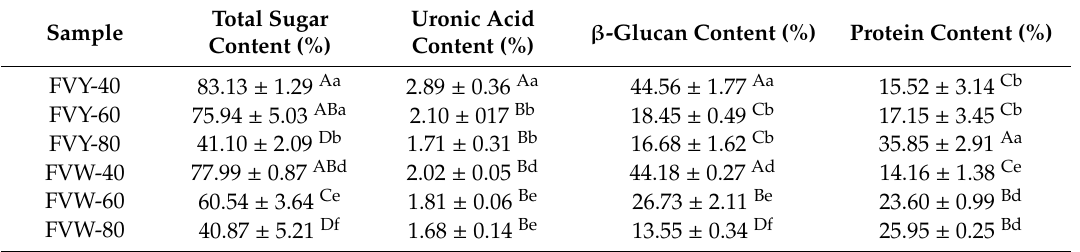
Table 1. Chemical composition of yellow strain and white strain polysaccharides. The results are presented as means ± standard deviations ( n =